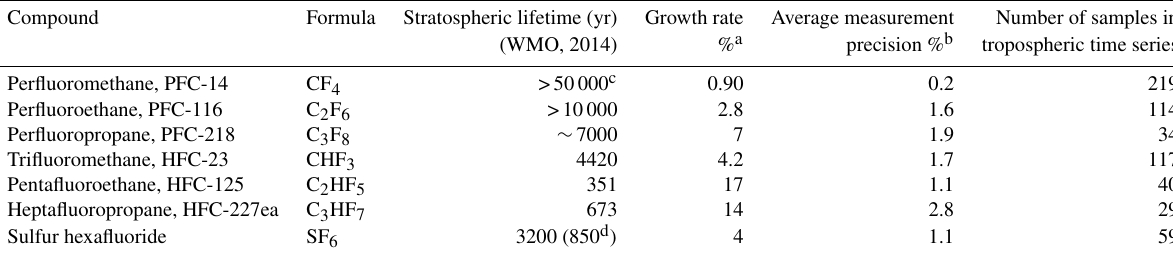
Table 1. Overview of trace gases used in this study and their relevant properties. Compound Formula Stratospheric lifetime (yr) Growth rate Average measurement Number of samples in (WMO, 2014) % a precision % b tropospheric time series Perfluoromethane, PFC-14 CF 4 >50000 c 0.90 0.2 219 Perfluoroethane, PFC-116 C 2 F 6 >10000 2.8 1.6 114 Perfluoropropane, PFC-218 C 3 F 8 ∼ 7000 34 Trifluoromethane, HFC-23 CHF 3 117 Pentafluoroethane, HFC-125 C 2 HF 5 Heptafluoropropane, HFC-227ea C 3 HF 7 673 Sulfur hexafluoride SF 6 3200 (850 d )